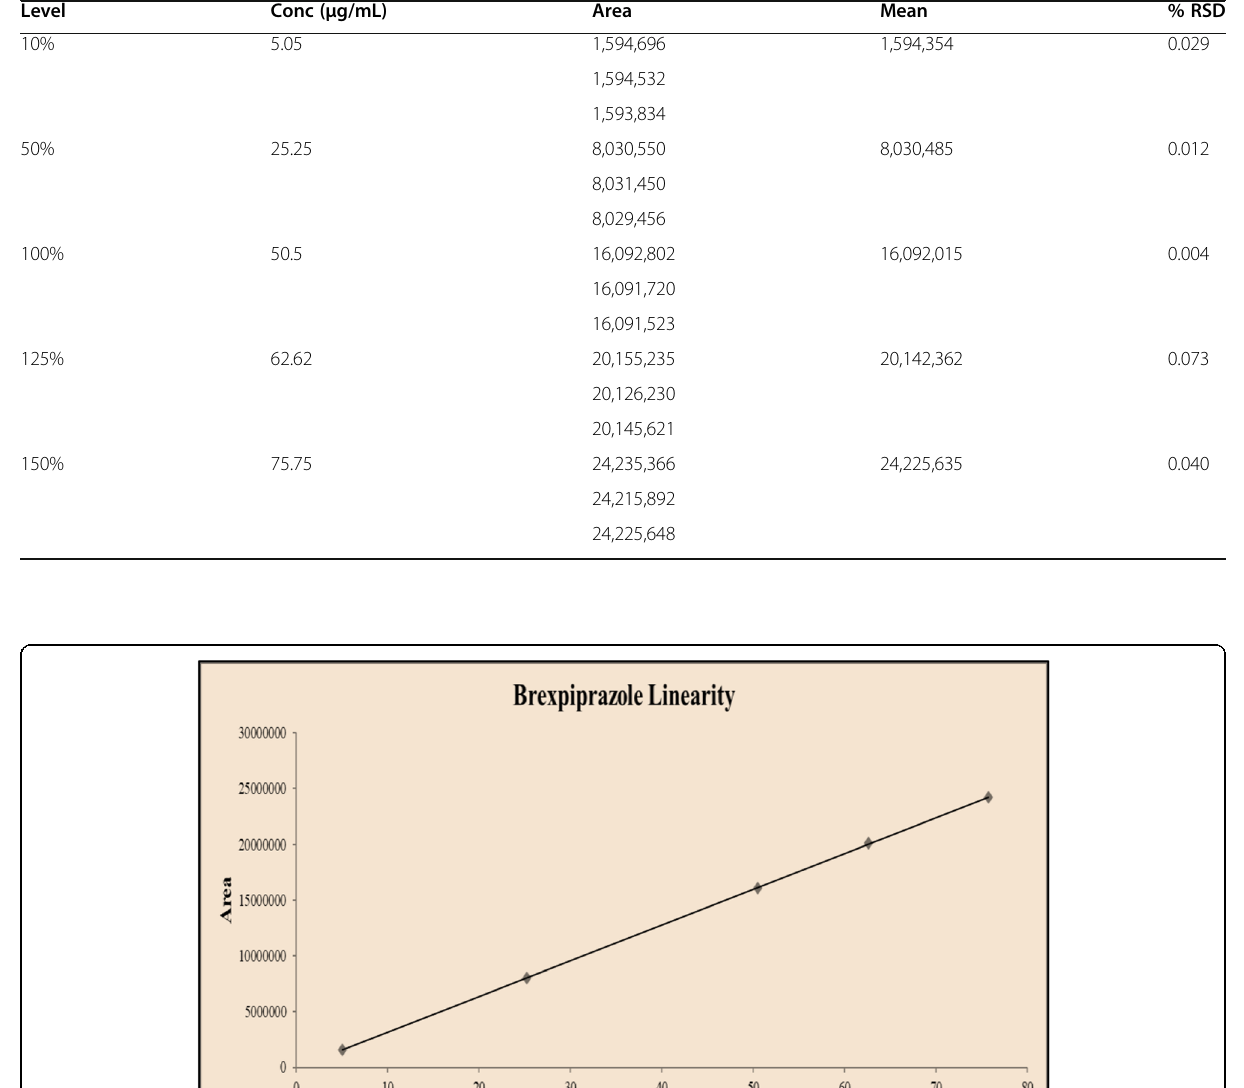
Table 13 Result and statistical data of linearity of brexpiprazole